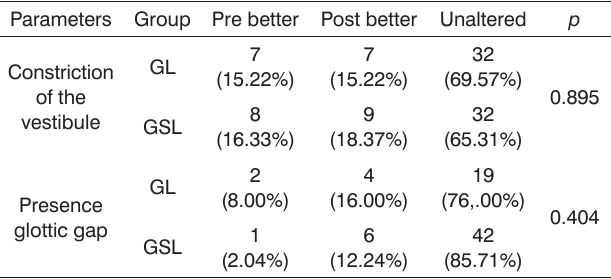
Table 5. Videolaryngoscopy of the parameters: constriction of the vestibule and glottic gap, before and after phonation into a straw